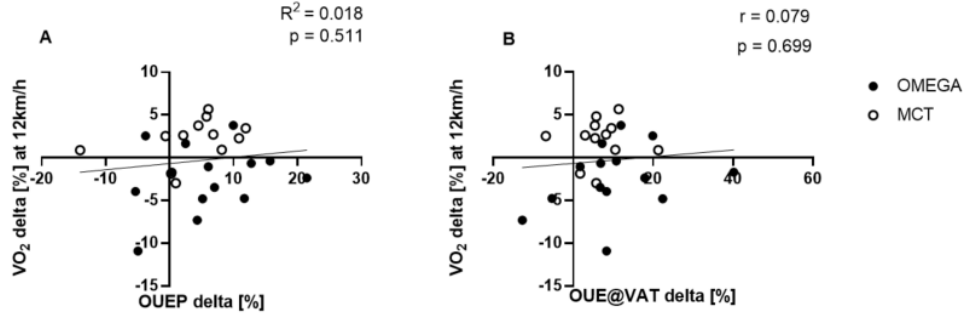
Figure 5. Correlation between changes in RE and OUEP ( A ) and OUE@VAT ( B ) after twelve weeks of combined endurance training and supplementation (OMEGA and MCT groups; n = 26).